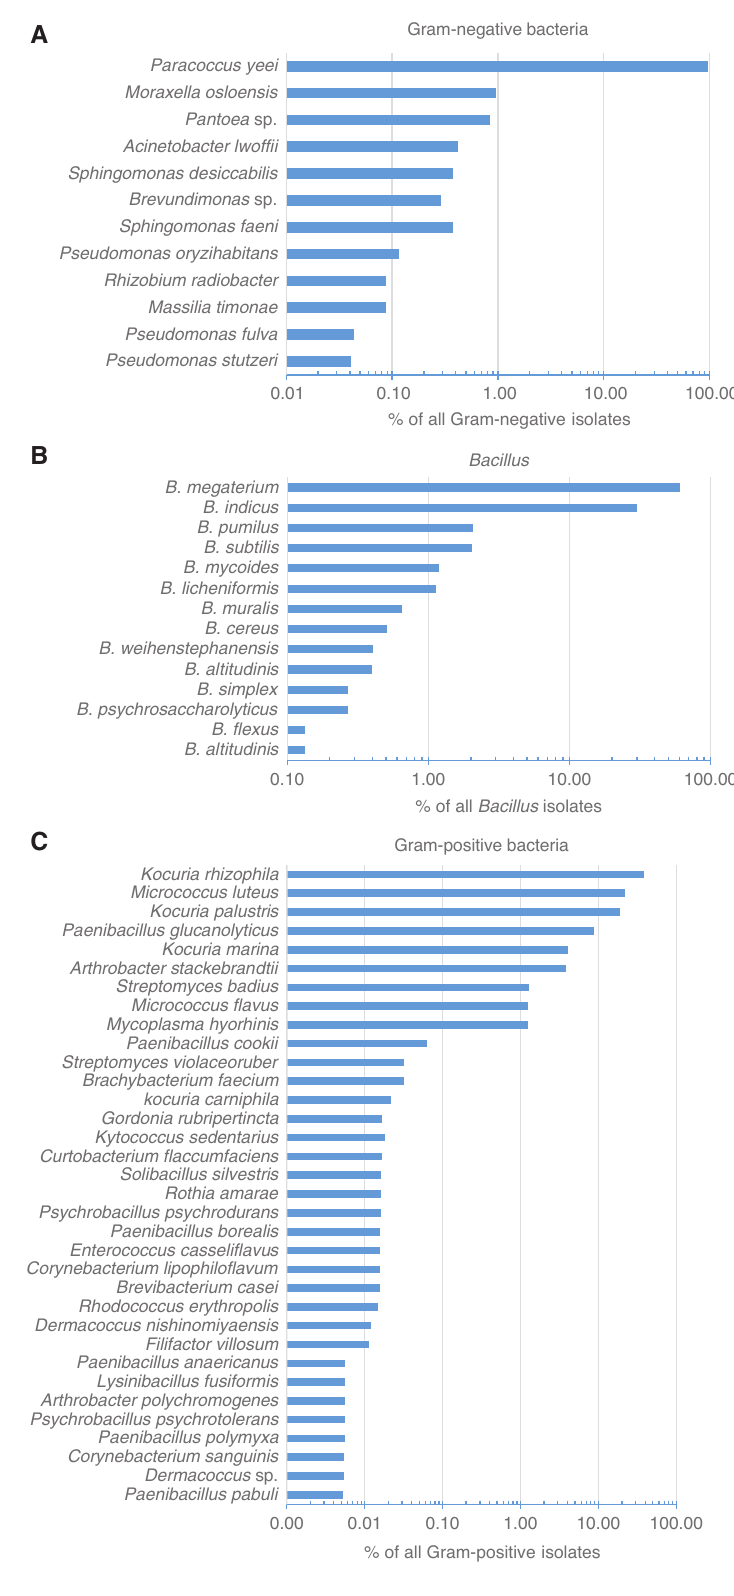
Figure 1 (A—C) Gram-negative bacteria (A), the 14 Bacillus species (B) and Gram- positive bacteria other than Bacillus and Staphylococcus (C) found in the living rooms of the five homes with one sample from each season (Study A); all presented as % of total isolates within the category. (Source: Authors,